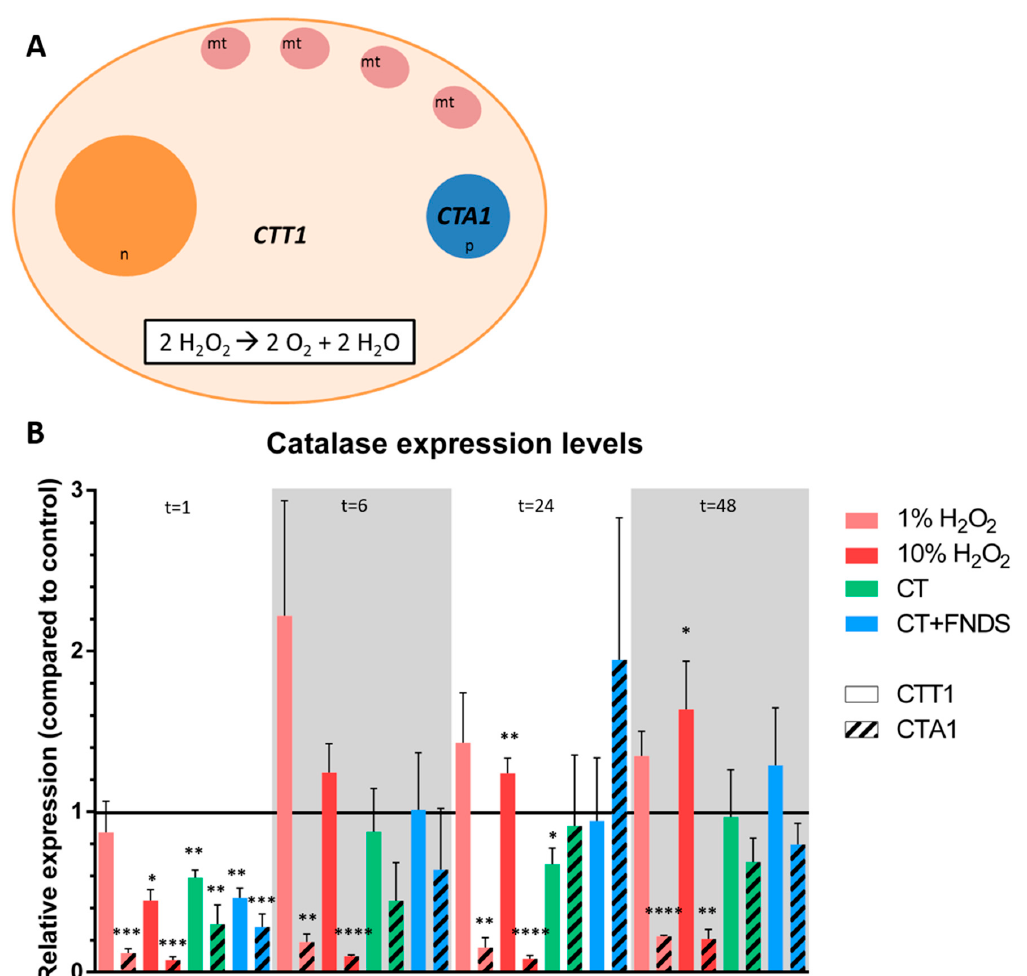
Figure 2. ( A ) Schematic representation of the cell showing the locations of catalase activity, including the reaction that is catalyzed by the catalase enzyme at both the cytoplasm (CTT1) and the peroxisomes (CTA1). (n = nucleus, mt = mitochondria, p = peroxisome); ( B ) Relative expression of catalase at di ff erent time-points: catalase T which is present in the cytoplasm (CTT1, filled bars) and peroxisomal catalase A (CTA1, striped bars). The colors represent di ff erent conditions, measured at 1 / 6 / 24 / 48 h, respectively. Values are averages out of three independent qPCR runs that were performed in duplicates. Error bars show the standard error of the mean. Significance was tested against the control (* p ≤ 0.05, ** p ≤ 0.01, *** p ≤ 0.001, **** p ≤ 0.0001).